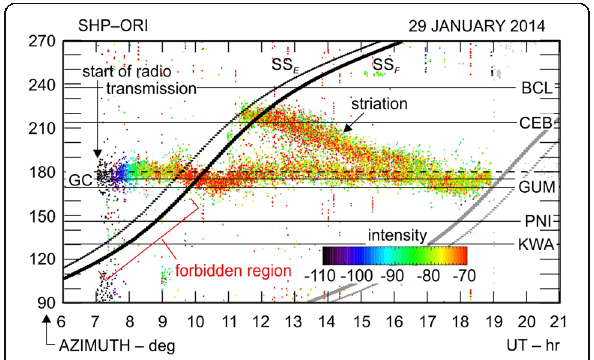
Fig. 9 An azimuth-time-intensity plot showing intensity of radio signals received at Oarai from Shepparton, on 29 January 2014. The horizontal trace was associated with propagation along a GC path; the downward- sloping trace (i.e., striation) was associated with propagation along an OGC path, which likely was supported by side reflections from the west wall of an upwelling. Plot is reproduced from Tsunoda et al.